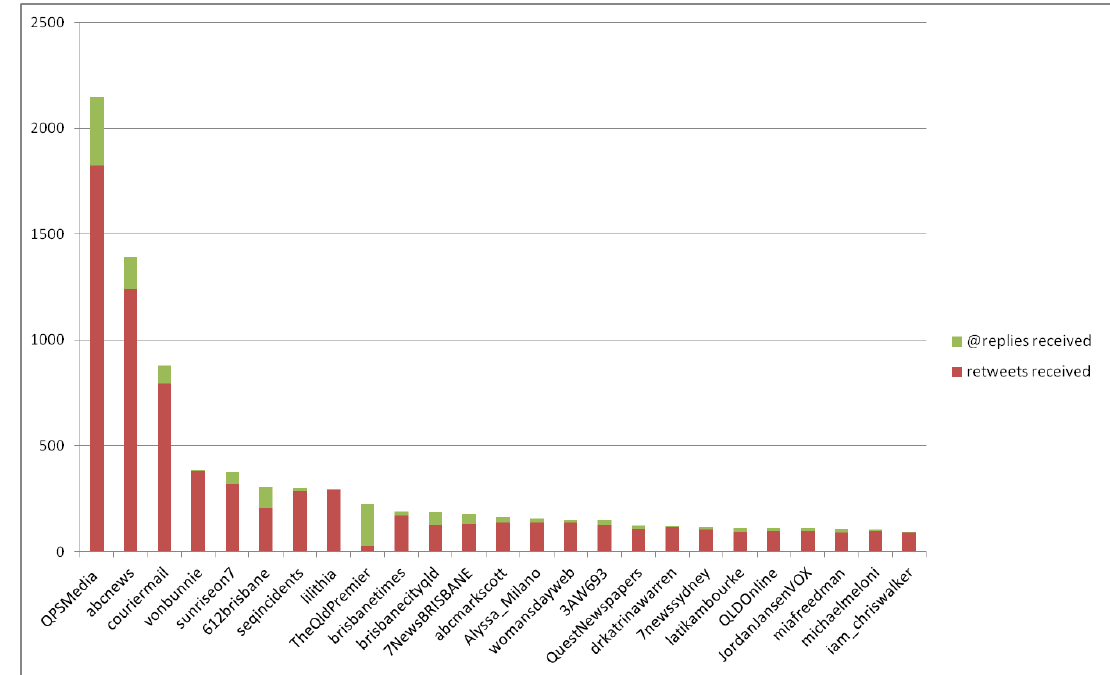
Fig. 1: @replies and retweets to #qldfloods users during 10-16 Jan. 2011 Fig. 1 also indicates the continuing importance of institutional sources during this event: